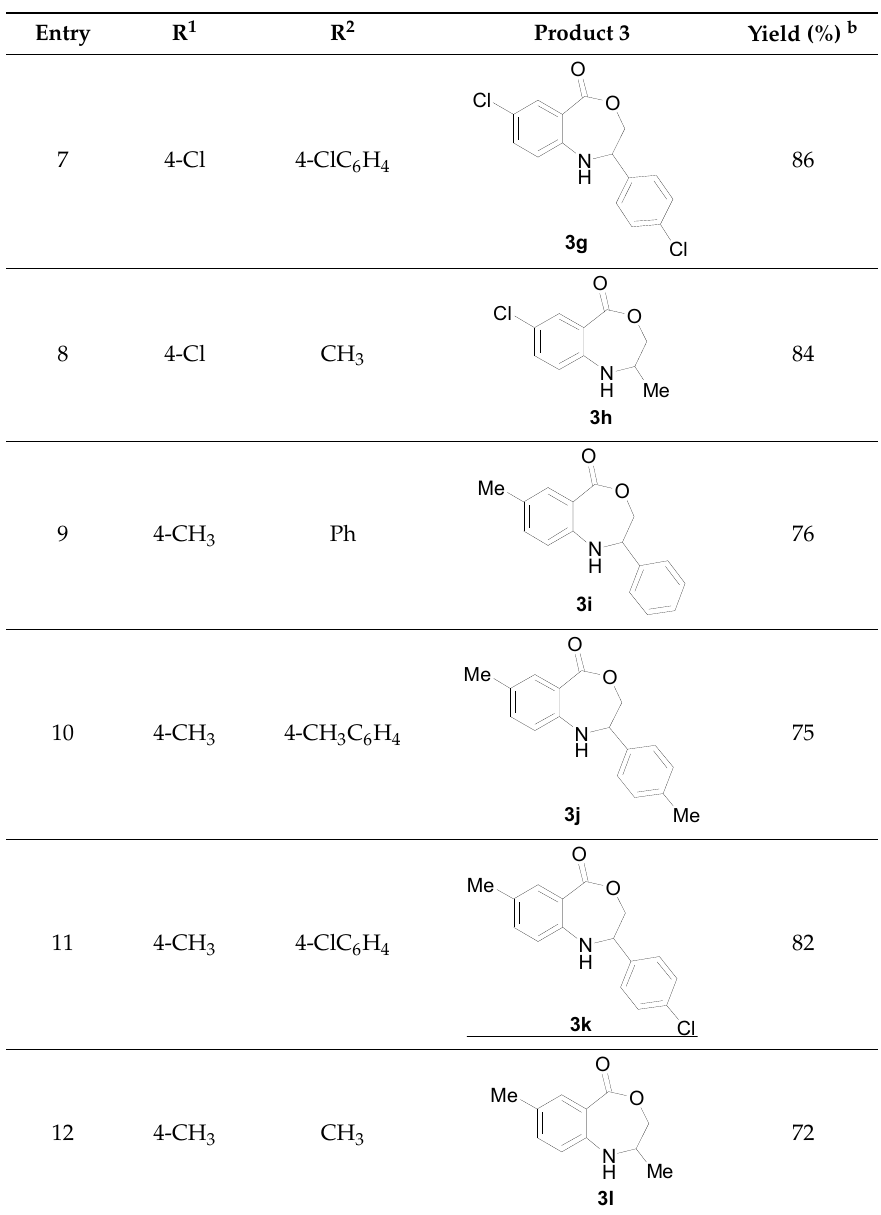
Table 3. Synthesis of benzo-1,4-oxazepin-5-one 5 a .